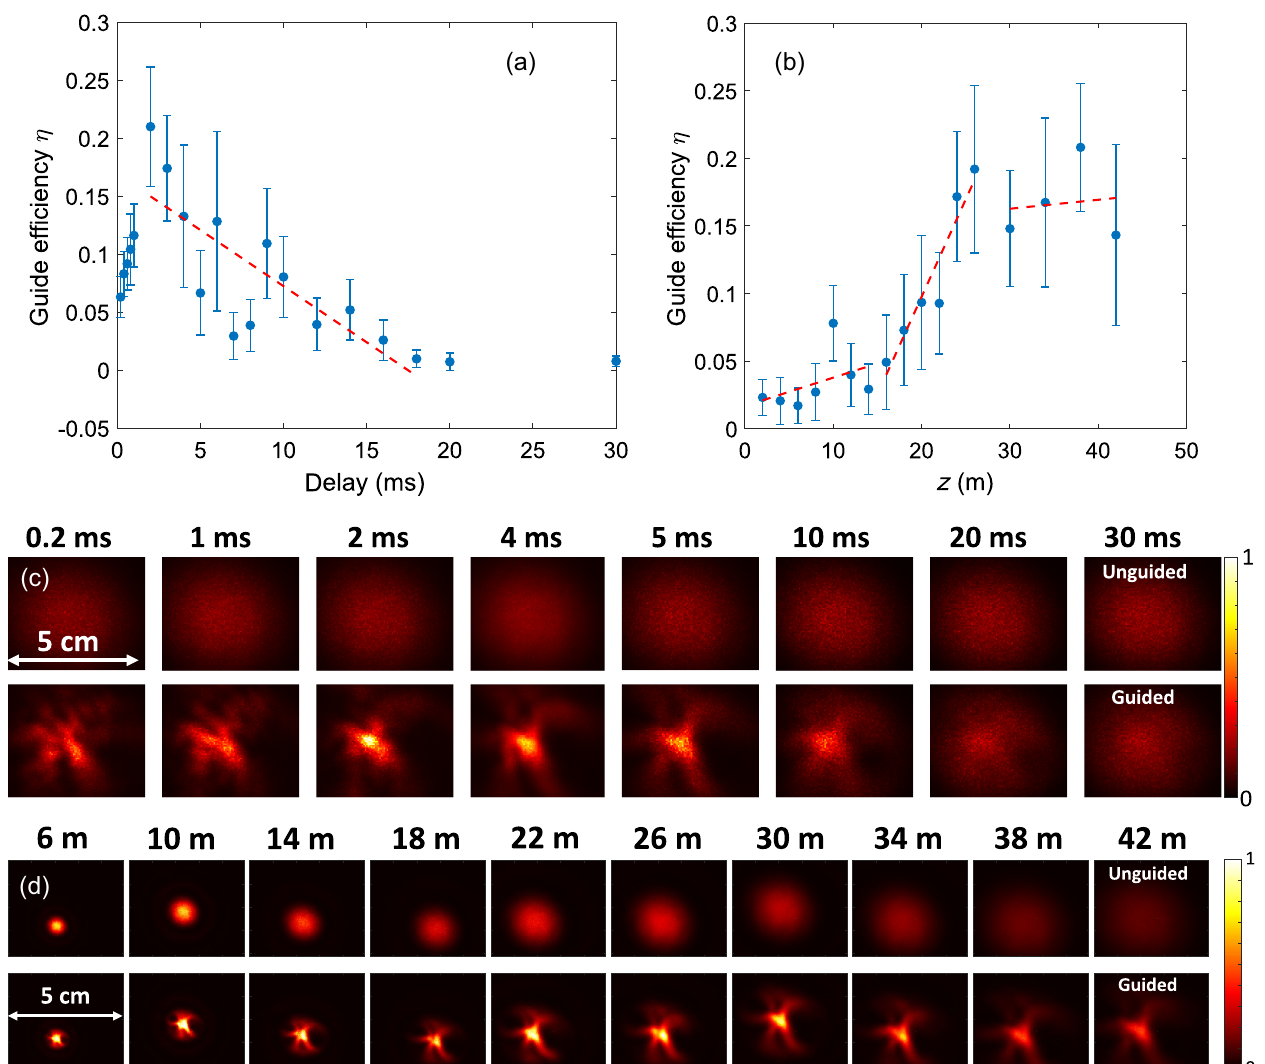
FIG. 8. Results from air waveguiding in 50-m range. Optical guiding of a 1-mJ, 7-ns, λ ¼ 532 -nm probe pulse injected into air 5 . 6 mm ( z 60 m). (a) Guiding efficiency η vs probe-pulse injection waveguide formed by a 120-mJ, 300-fs LG 01 pulse with d 0 ¼ ring ¼ delay measured at z ¼ 42 m. (b) Guiding efficiency η vs z along the waveguide for 5-ms injection delay. Each point in (a) and (b) is a 100-shot average, and the error bars are the (cid:3) standard deviation. (c) Guided-probe modes measured at z ¼ 42 m vs injection delay. (d) 100-shot-average images of unguided (top row) and guided (bottom row) mode vs propagation